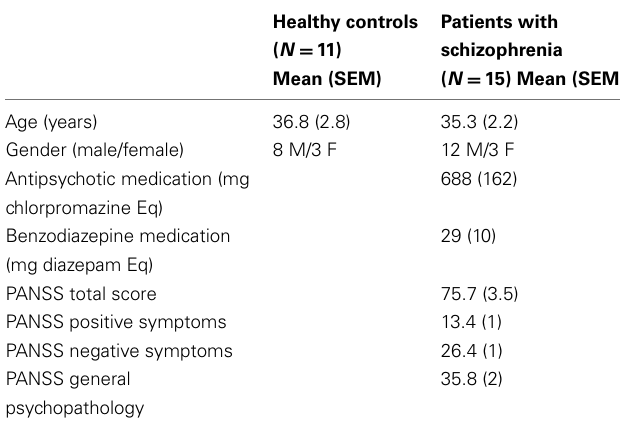
Table 1 | Population